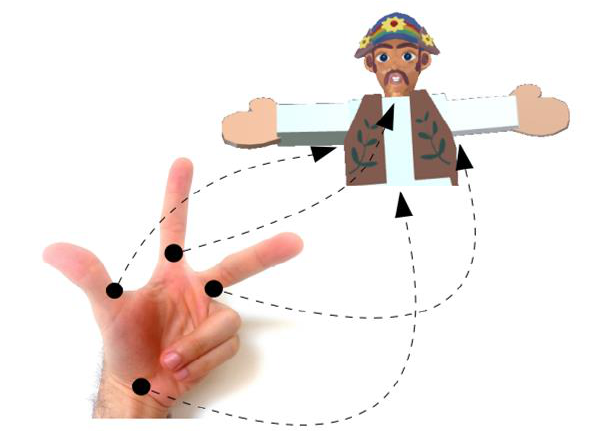
Figure 8. Association scheme between hand and puppet